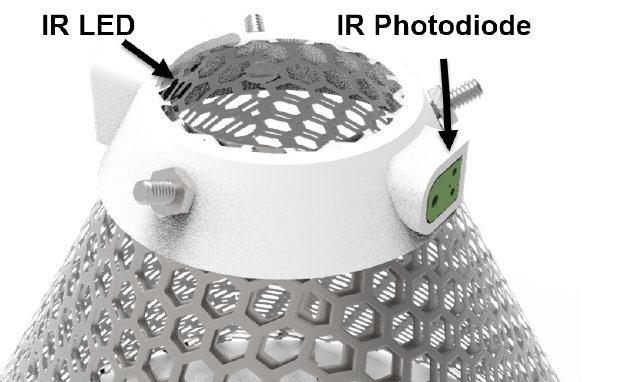
Figure 4. A render of the light emitting diode and photodiode arrangement for counting corn earworm moths as they enter the trap via the funnel.